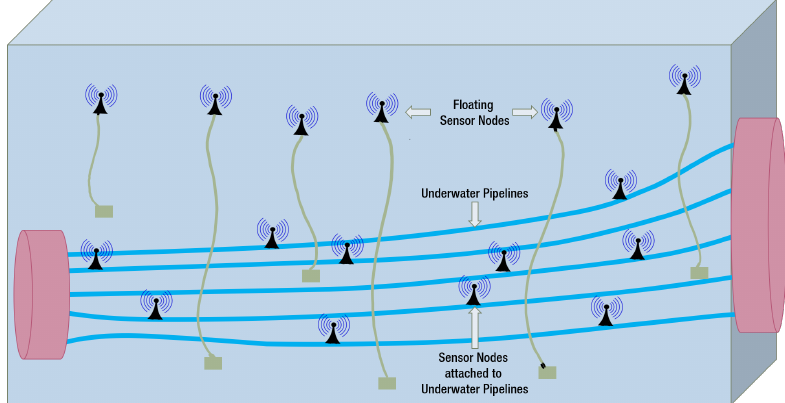
Figure 1. Underwater Pipeline Monitoring with